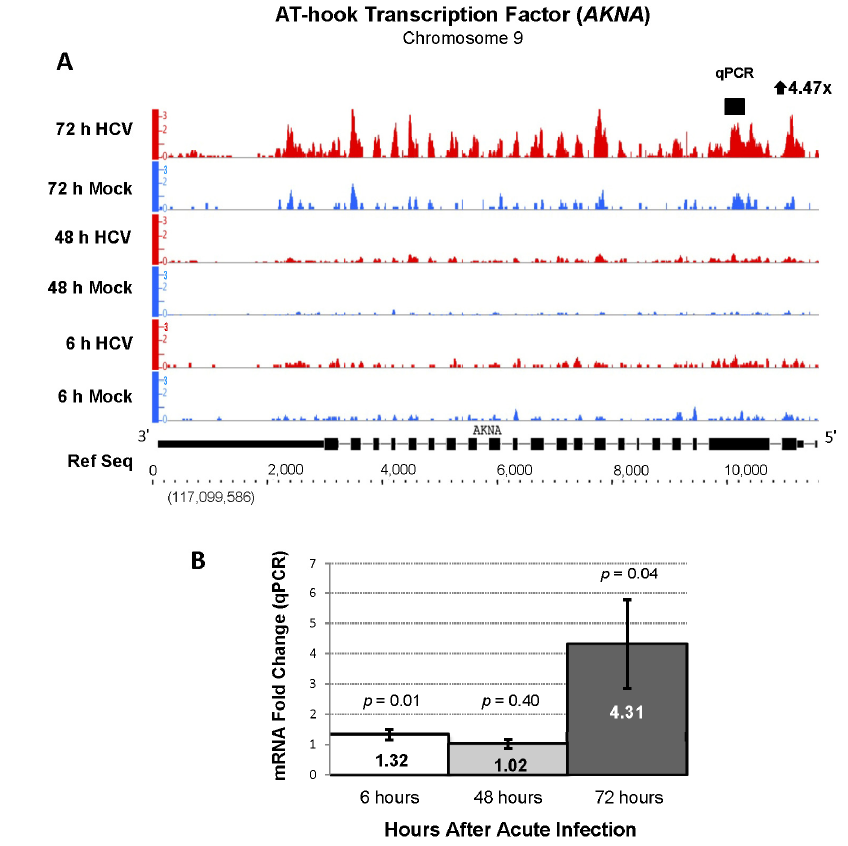
Figure 5. Increased expression of AT-hook transcription factor ( AKNA , Chr 9, − strand) during acute HCV infection. ( A ) RNA sequencing analysis showed a 4.5-fold increase with an FDR of 773.3 and ( B ) qPCR showed a 4.3-fold increase in AKNA mRNA at 72hr after HCV